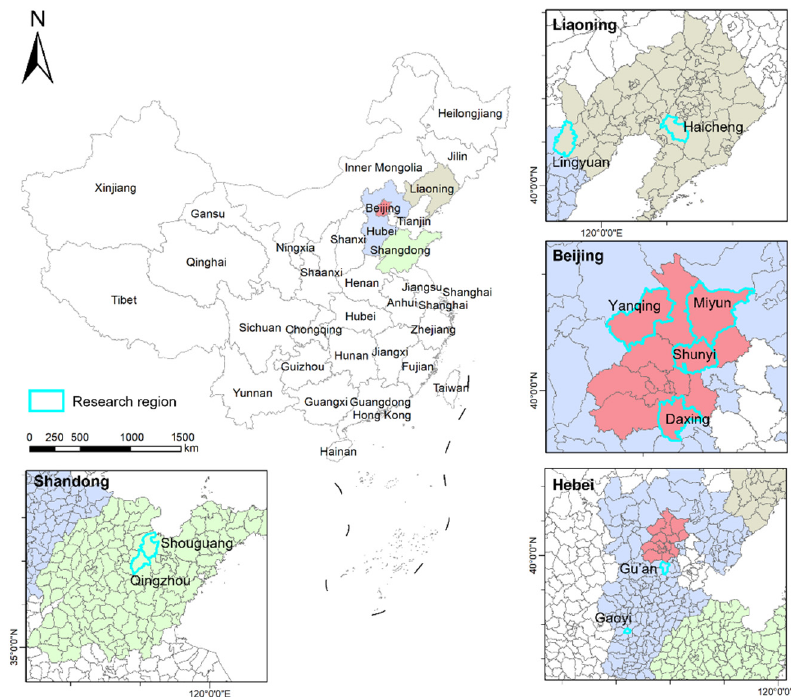
Figure 1. A description of the survey regions.